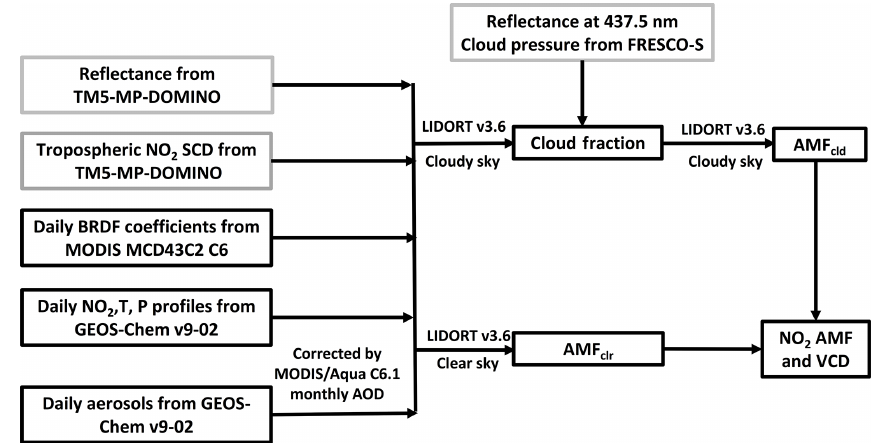
Figure 1. Flowchart of the POMINO-TROPOMI algorithm. The grey rectangles represent the parameters from the TM5-MP-DOMINO (OFFLINE) product.